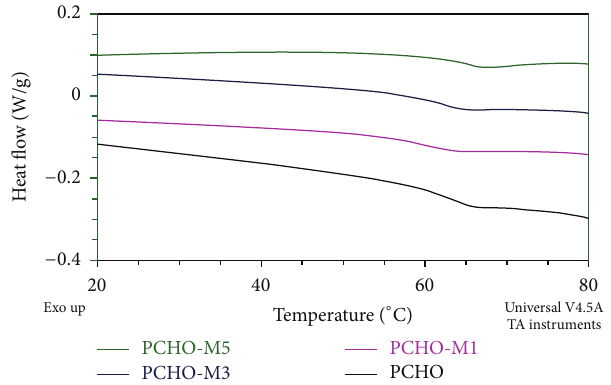
Figure 6: DSC data of pristine polymer and nanocomposites.